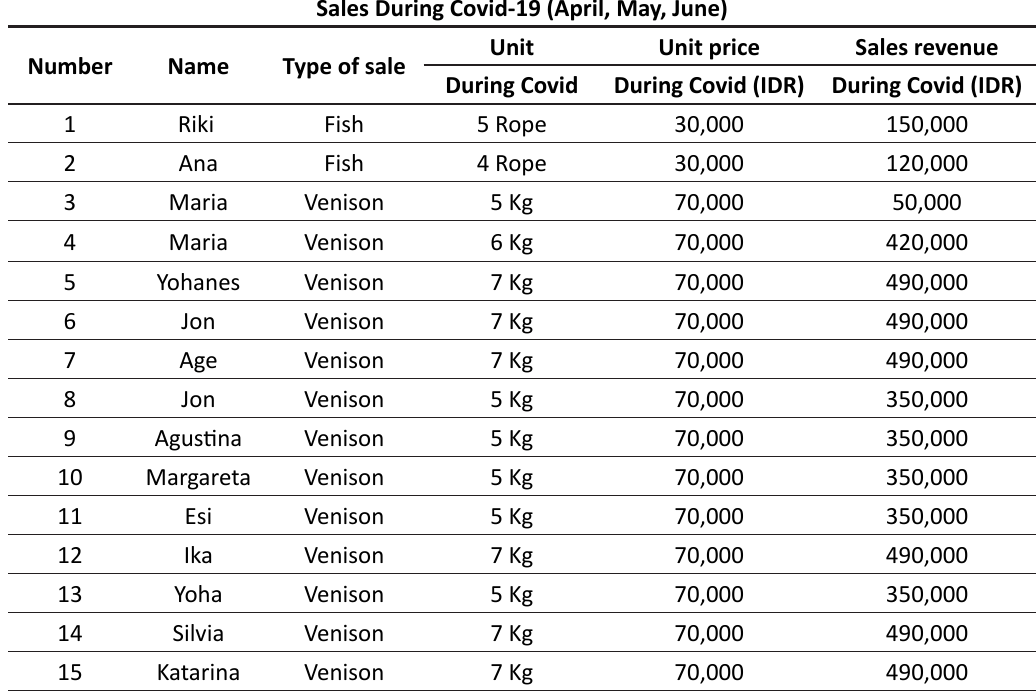
Table 1: Revenue from Sales during Covid-19 at Mopah Market Sales During Covid-19 (April, May,